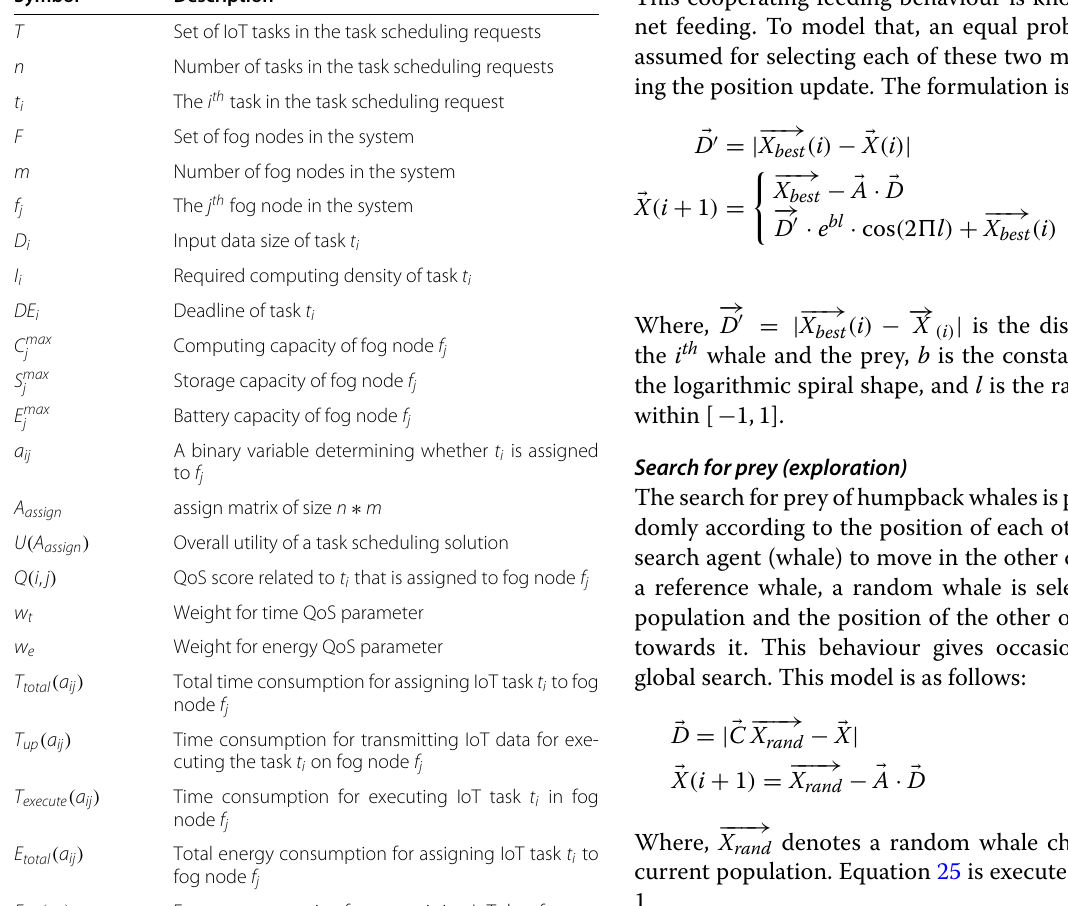
Table 2 Description of used notations Symbol